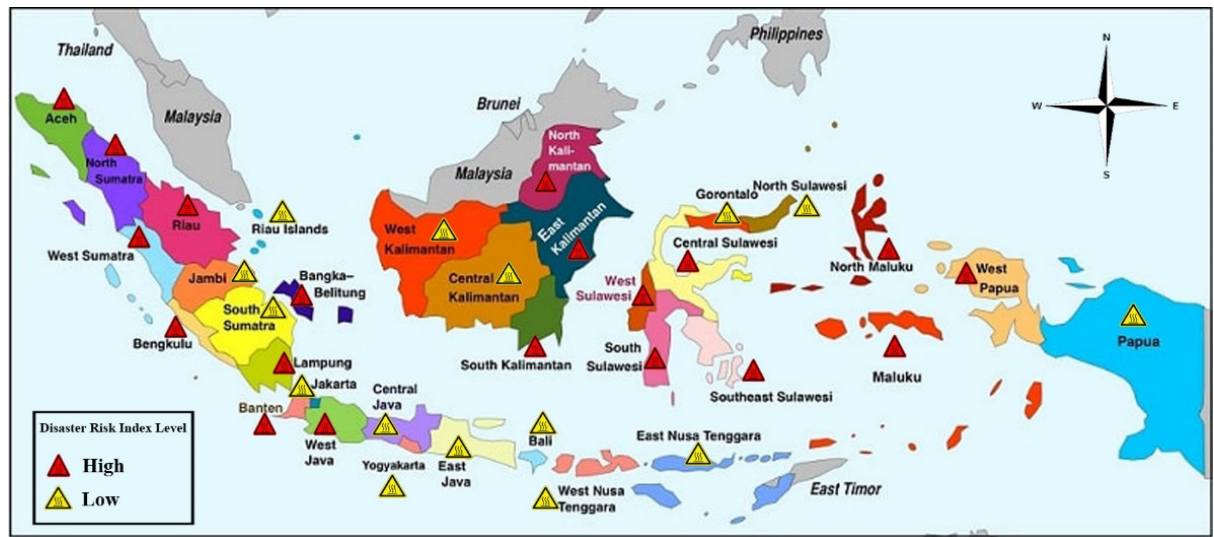
Figure 4. Map of disaster risk index in each province in Indonesia.